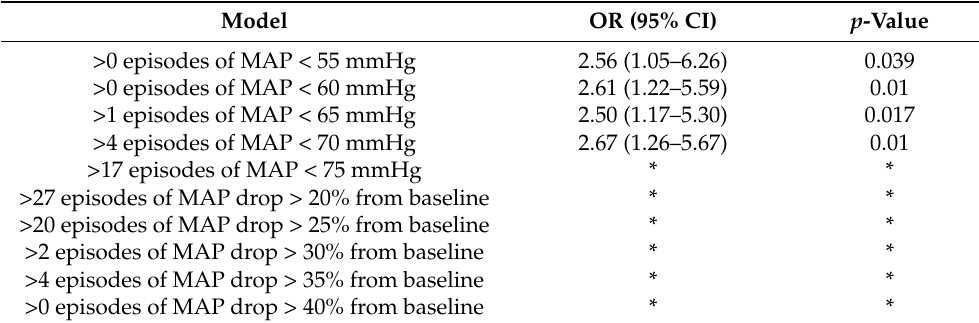
Table 5. Multivariable logistic regression models for prediction of the hypoperfusion-related events. Adjusted for chronic kidney disease, procedure duration and arterial hypertension (Supplementary Materials: Table